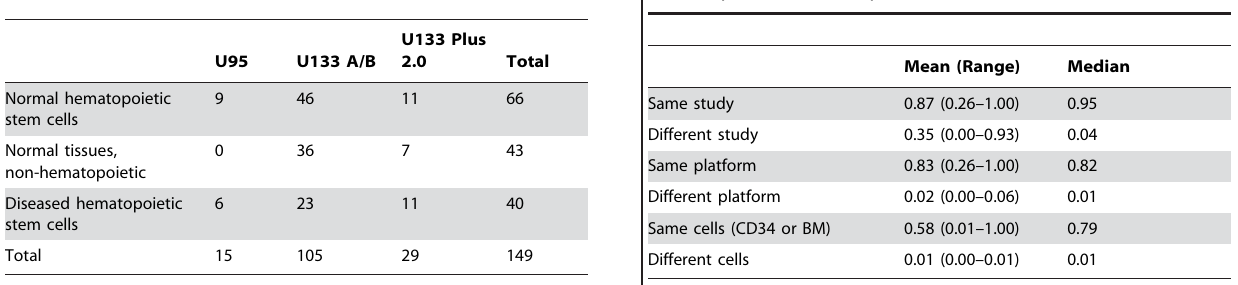
Table 3. Pairwise absolute correlation coefficients for normal hematopoietic cell